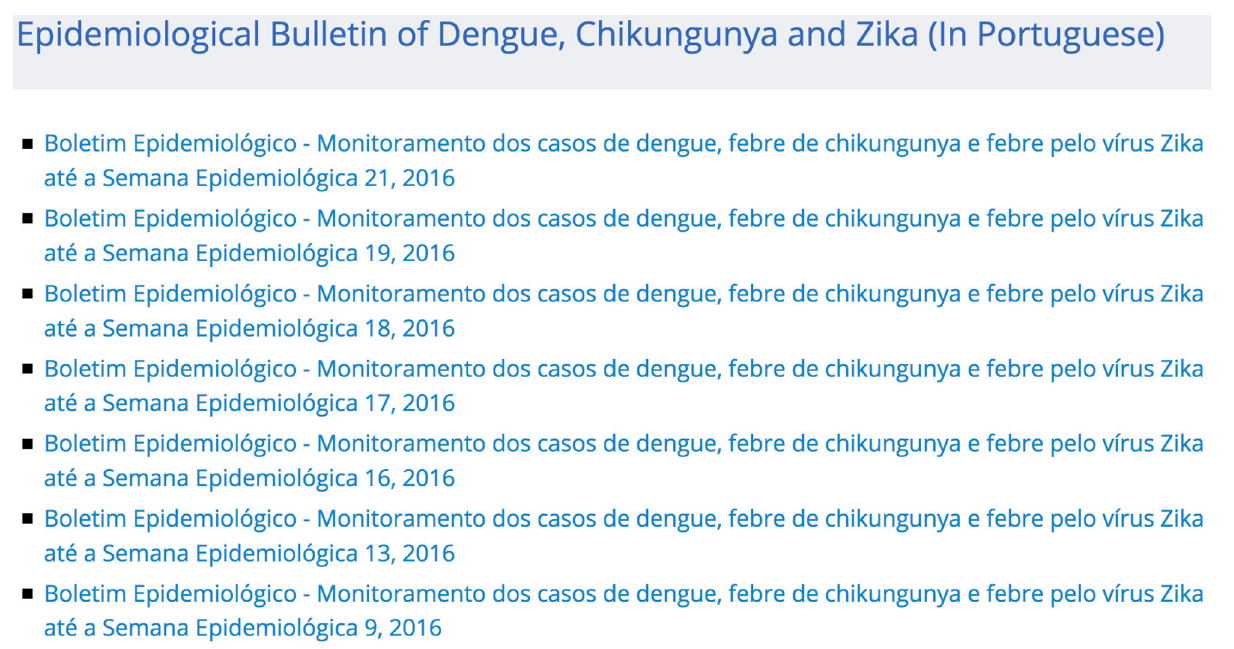
document is published, as well as epidemiological subject